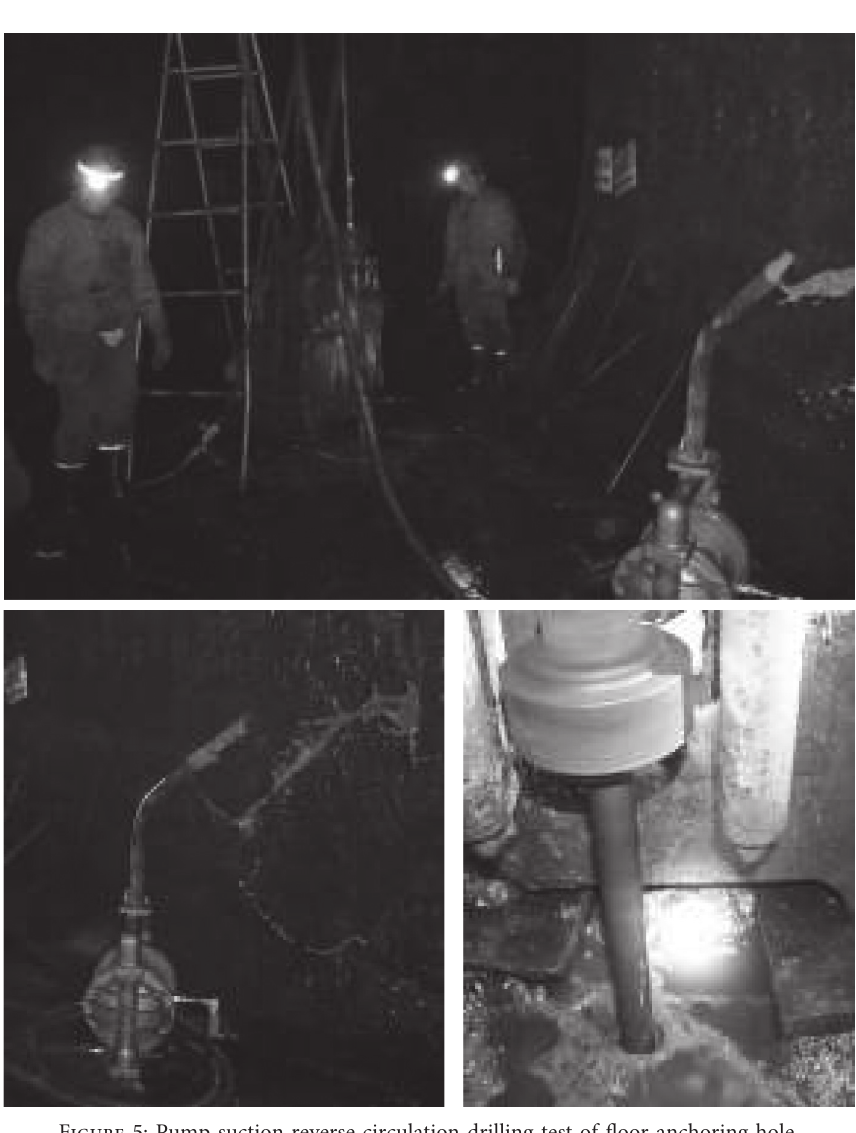
Figure 5: Pump suction reverse circulation drilling test of floor anchoring hole.